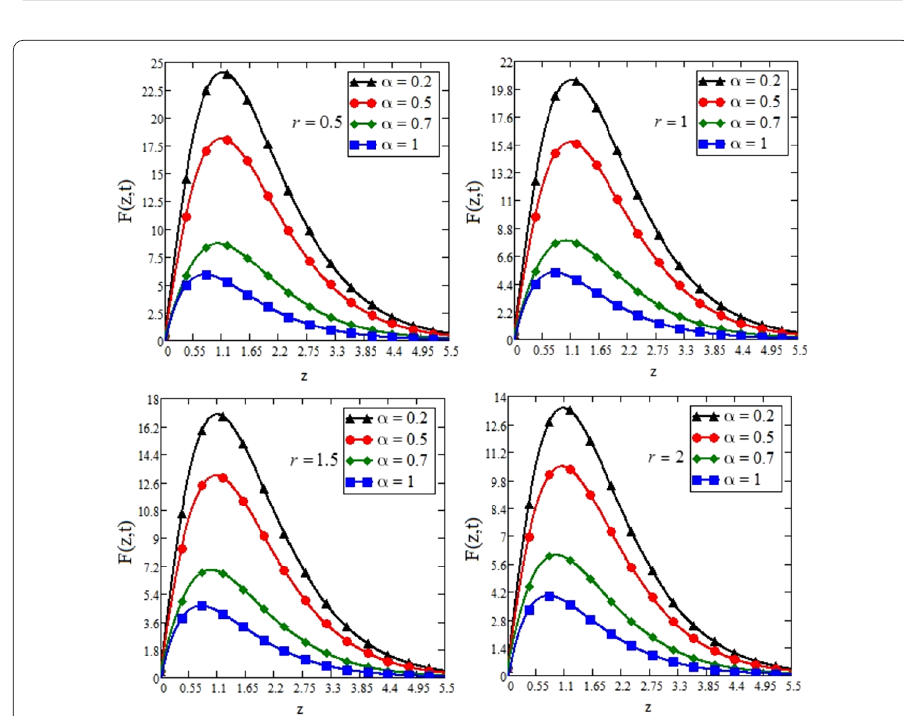
Figure 10 Impact of r on the velocity distribution of Jeffrey